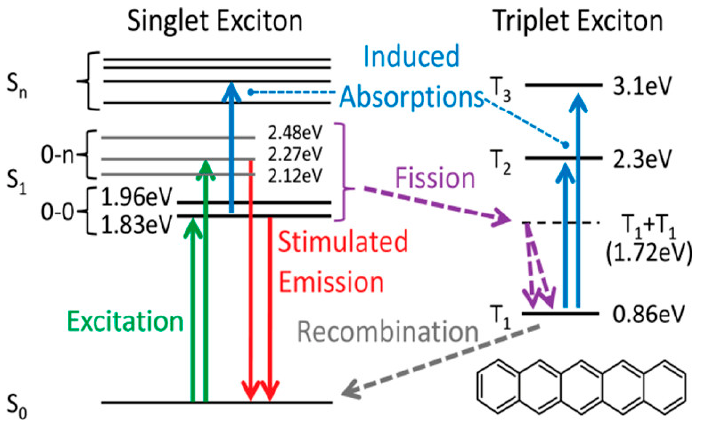
Figure 3. Partial Jablonski diagram of crystalline pentacene. Reprinted with permission from Ref. [73]. Copyright 2013, American Chemical